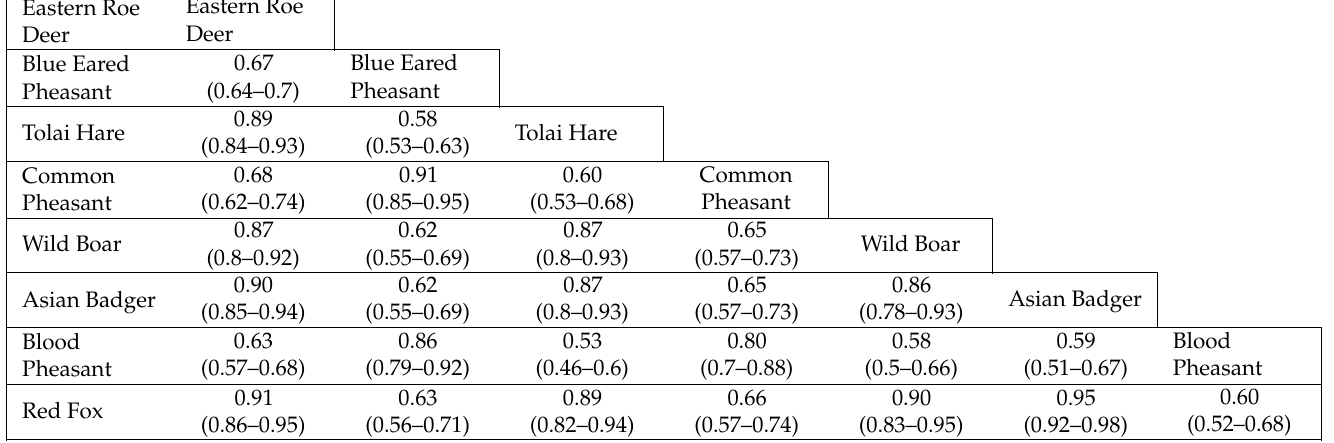
Table 2. Coefficients of daily activity overlapping (Dhat4) and their confidence intervals (CI) for eight animal species on the eastern Qinghai-Tibet Plateau in